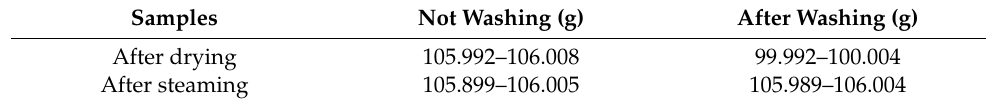
Table 3. The dry weight of the fabrics at different stages of the pad–dry–steam process before and after washing.